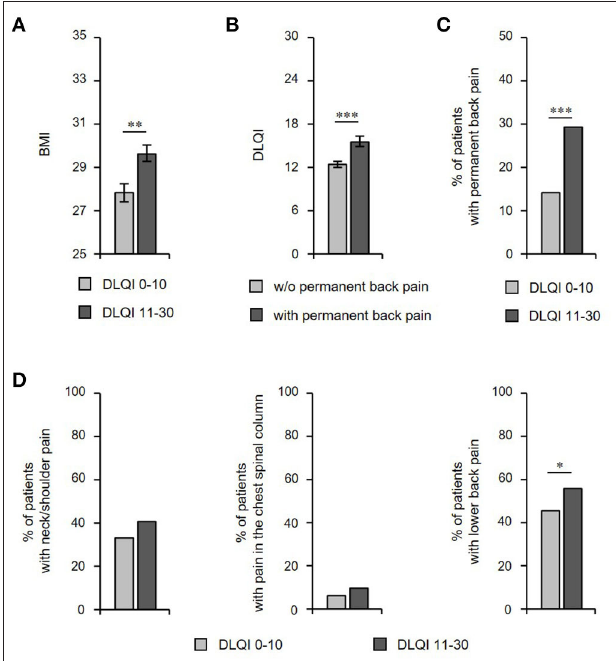
FIGURE 6 | Impairment of QoL is associated with HS comorbidities. (A) BMI ( n = 437) in HS patients with small/moderate (DLQI ≤ 10) vs. very/extremely large (DLQI > 10) QoL impairment is given as mean ± SEM. The significance of differences was assessed using the Mann-Whitney U test (two-tailed; ** P ≤ 0.01). (B) DLQI scores of HS patients with or without very frequent/permanent back pain are presented as mean ± SEM ( n = 462). The significance of differences was assessed using the Mann-Whitney U test (*** P < 0.001). (C) The frequency of HS patients ( n = 462) with very frequent/permanent back pain in patients with small/moderate (DLQI ≤ 10) vs. very/extremely large (DLQI > 10) QoL impairment is provided. The significance of differences was assessed using the Chi-square test (*** P ≤ 0.001). (D) The frequency of HS patients ( n = 462) showing pain of neck/shoulder (left), chest spinal column (middle), and lower back (right) among patients with small/moderate (DLQI ≤ 10) vs. very/extremely large (DLQI > 10) QoL impairment is provided. The significance of differences was assessed using the Chi-square test (* P < 0.05). BMI, body mass index; DLQI, Dermatology Life Quality Index.